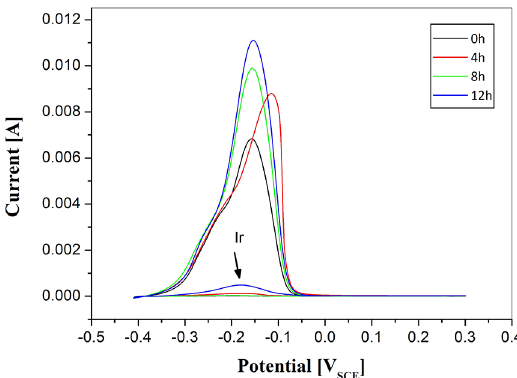
Figure 4. DL-EPR curves of specimens solution treated (0h), aged at 475 o C for 4 h, 8 h and 12 h.